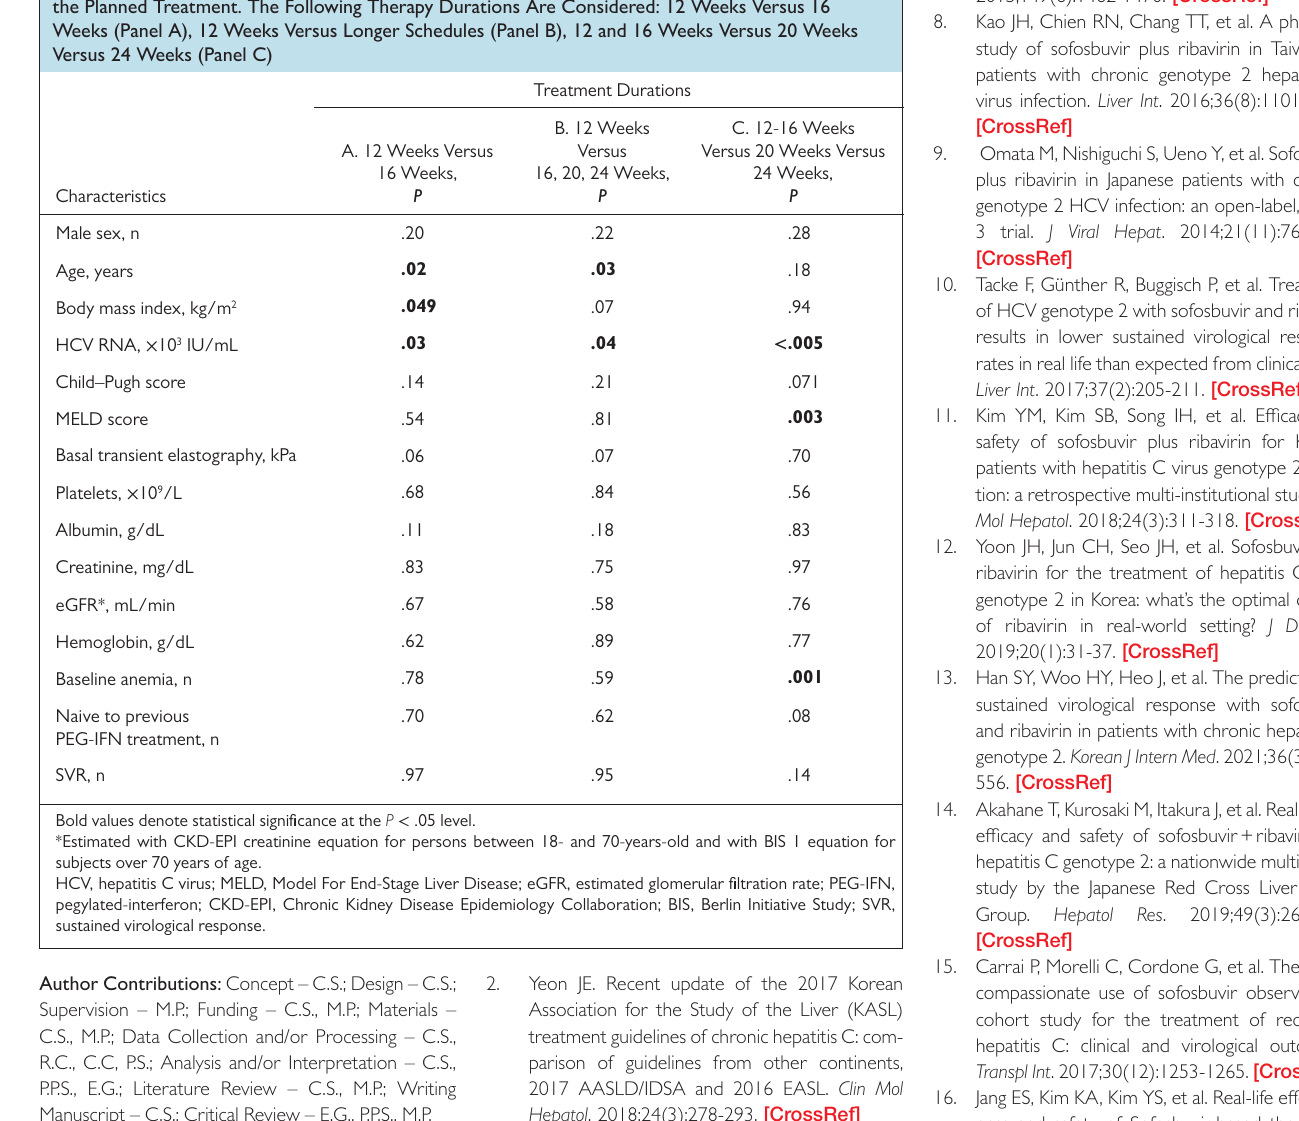
Table 6. Comparison of the Main Demographic and Clinical Parameters of Patients Who Completed the Planned Treatment. The Following Therapy Durations Are Considered: 12 Weeks Versus